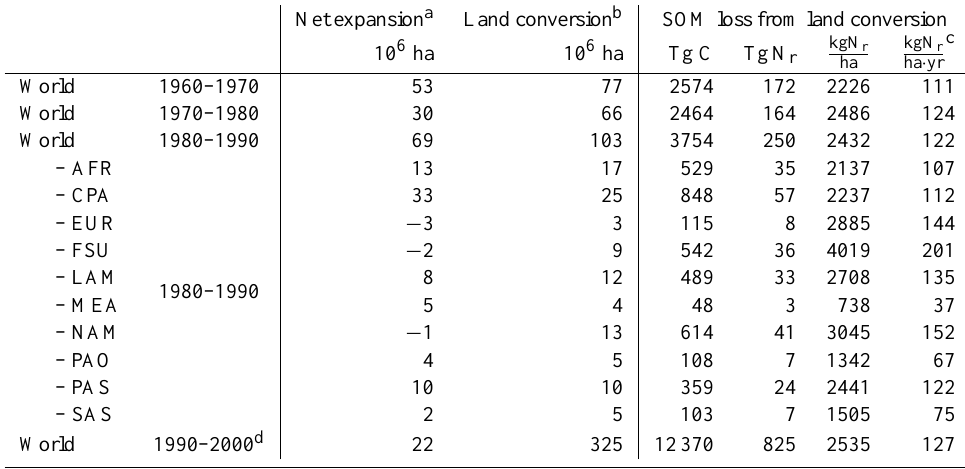
a Net expansion counts the aggregated change in regional or global cropland, and thus the difference of expansion and contraction. b Land conversion sums up the expansion of each geographic grid cell into land which was not used as cropland since the year 1900. Contracting cropland is not substracted. c Assuming that the soil organic matter is lost over 20yr. d Estimates for 1990–2000 are too high and should not be used (see